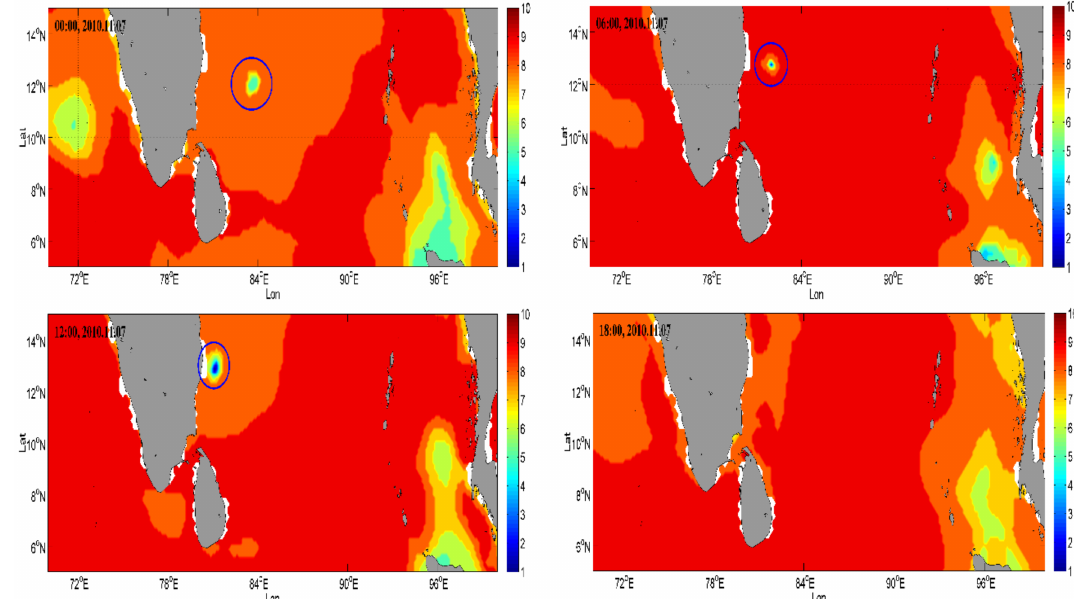
Figure 8. Vis results from the ANN method under tropical storm weather conditions. Tracking a tropical storm in the Indian Ocean from 6 to 7 November 2010. Its low-pressure center is indicated by blue ovals. The color bar indicates the Vis